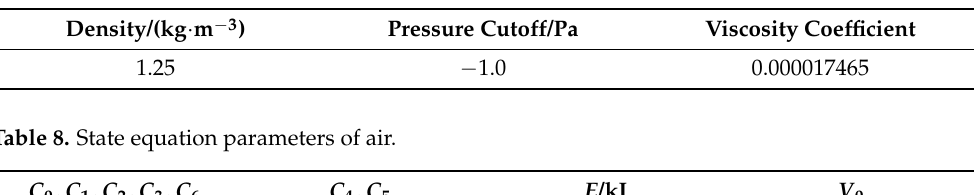
Table 7. Material parameters of air.